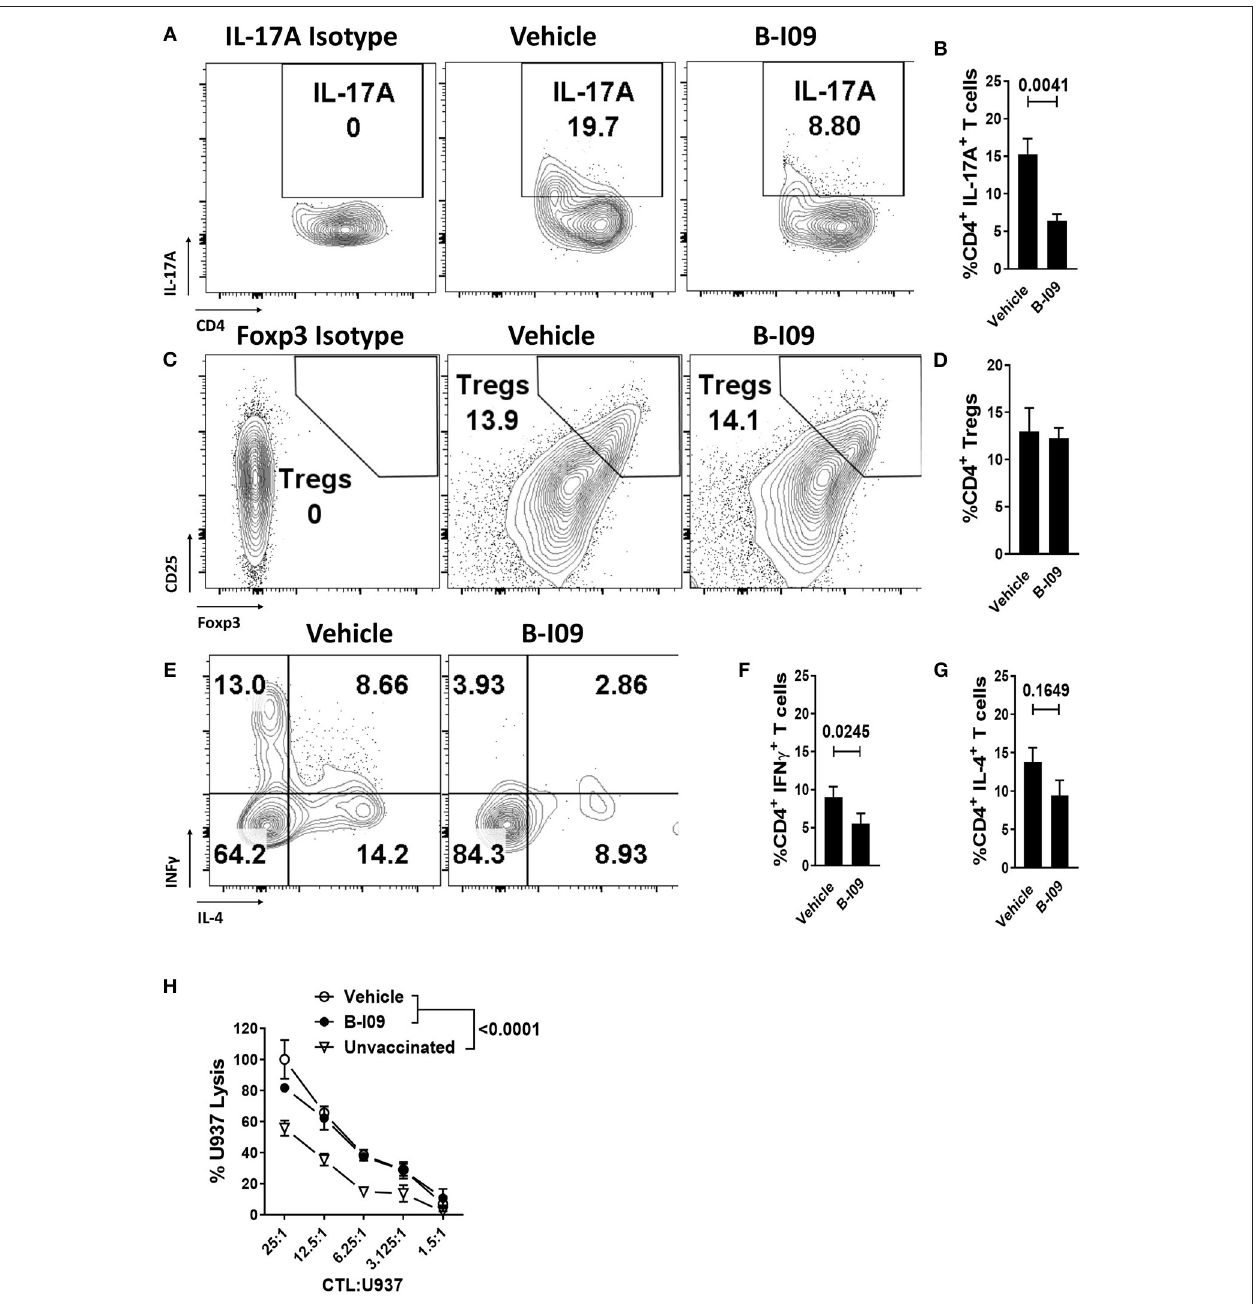
FIGURE 7 | XBP-1s inhibition reduces pathogenic Th17 and Th1 cells, yet preserves generation of anti-tumor CTL and Tregs in vivo . NSG mice were transplanted with human skin grafts and allogeneic PBMCs and treated with vehicle or B-I09 exactly as described. On day + 21, the mouse spleens were harvested and human T cell phenotypes were determined by flow cytometry. The amount of human (A,B) Th17s (CD4 + , IL-17A + ), (C,D) Tregs (CD4 + , CD127 − , CD25 + , Foxp3 + ), Th1s (CD4 + IFN γ + ), and Th2s (CD4 + , IL-4 + ) (E–G) isolated from the recipient spleen at day + 21 are shown. Pooled data from two independent experiments, up to 7 mice per group, Mann-Whitney test. (H) Replicate mean specific lysis by human CD8 + CTL generated in vivo using NSG mice transplanted with human PBMCs (30 × 10 6 ) and vaccinated with irradiated U937cells (10 × 10 6 ) on days 0 and + 7. Mice received B-I09 or vehicle as described. For these experiments, recipients did not receive human skin. U937 lysis was measured by a colorimetric assay after 4h using purified human CD8 + T cells from recipient spleens at days + 10–12. Replicate mean tumor lysis values shown are from 1 of 2 independent experiments, Tukey’s